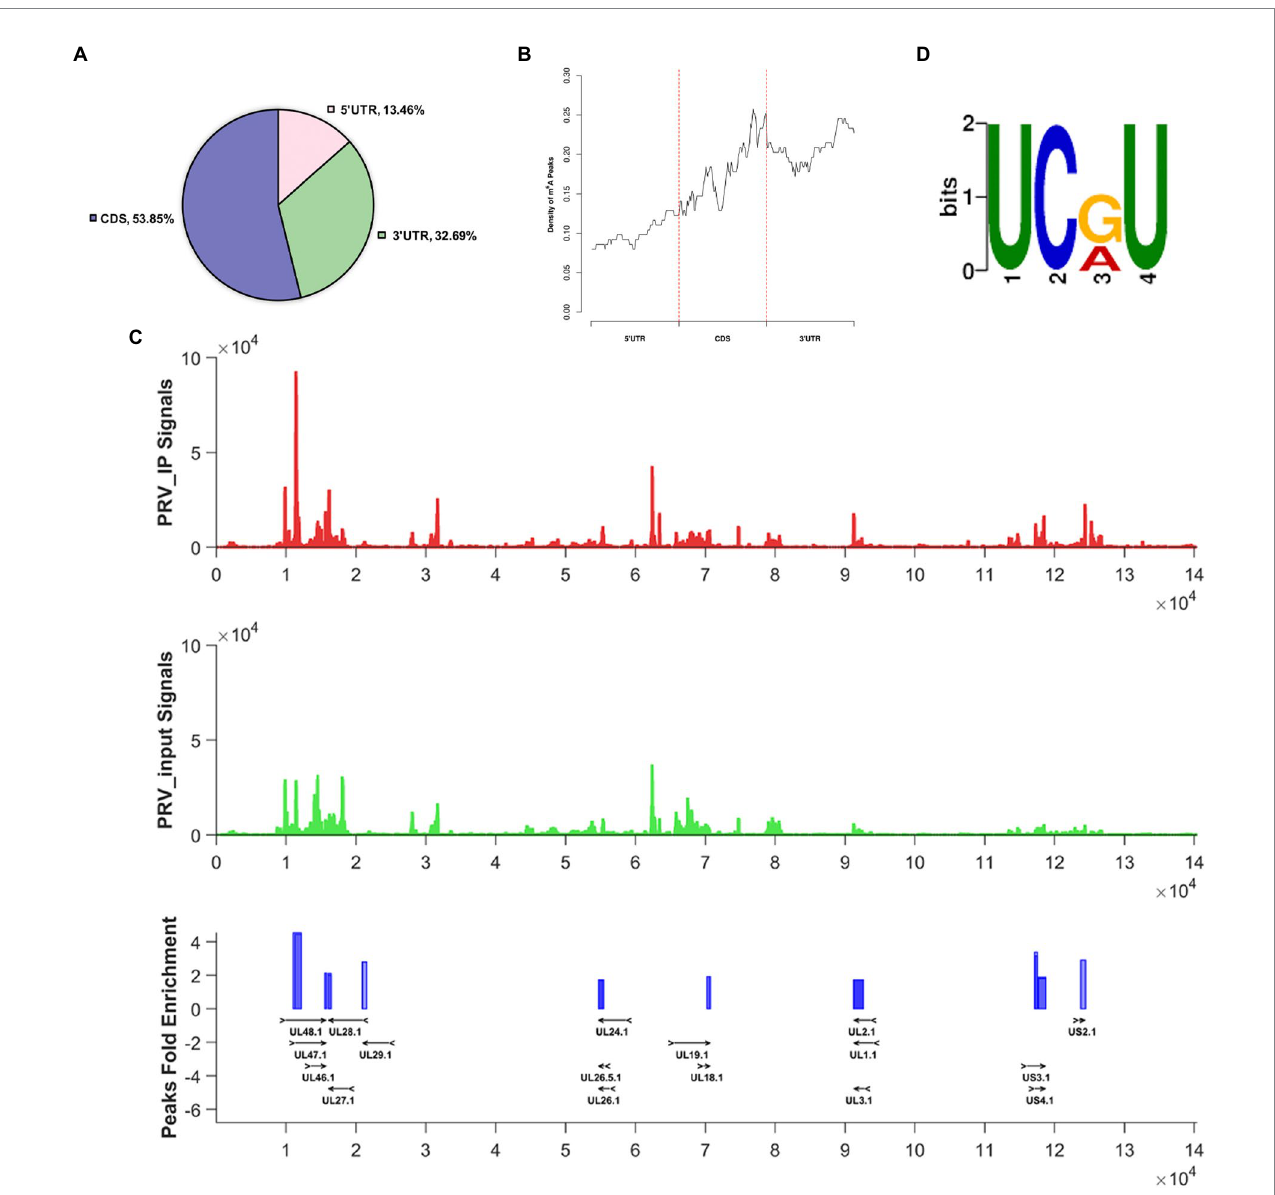
FIGURE 1 The status of m 6 A modification on PRV transcripts. For PRV (MOI = 1) infection, total RNA of PK15 cells was harvested at 24 hpi. (A) Distribution pattern of m 6 A peaks on PRV transcripts was analyzed based on the MeRIP-seq data (NCBI #GSE209949). (B) Density of m 6 A peaks on PRV transcripts. (C) Transcriptome-wide mapping to PRV m 6 A IP reads, input reads and m 6 A peaks based on MeRIP-seq. The m 6 A peaks of PRV transcripts were indicated as blue blocks. The input and PRV IP coverage were indicated with green and red bars, respectively. All genes were shown and overlaid as black arrows in the bottom track. (D) Motif analysis to identify consensus sequences for PRV transcripts. The most prominent motif was